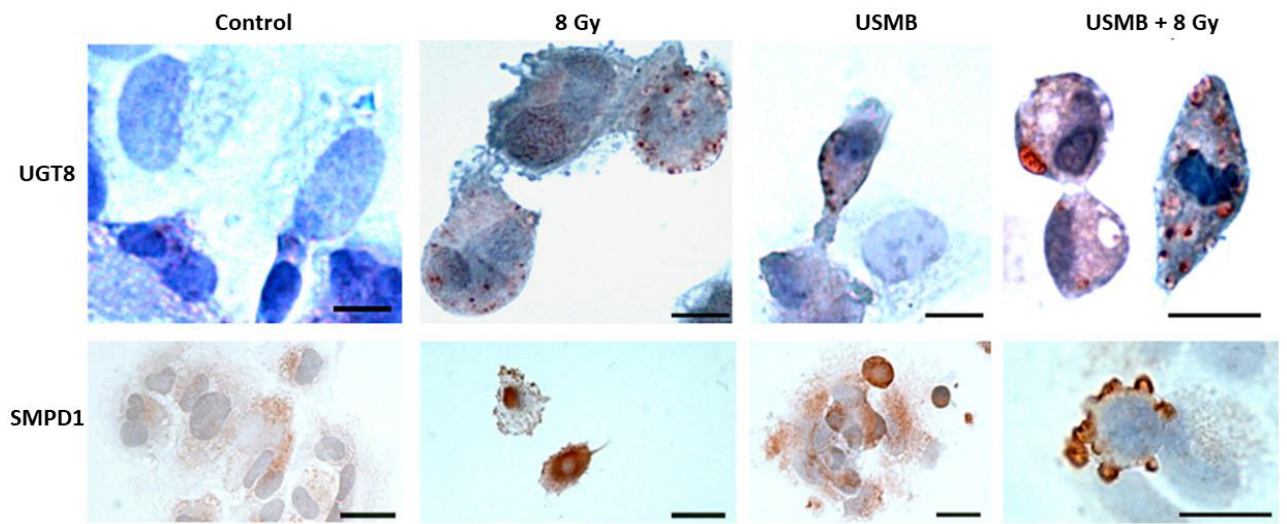
Figure 5. UGT8 and SMPD1 immunohistochemistry of HUVEC following different conditions. The upper panel images depict UGT8 and the lower panel represents SMPD1 following various treat- ments. Both UGT8 and SMPD1 stains were higher in the combined treated group. Cells appeared to have distorted morphology, indicating apoptosis-like features in both UGT8 and SMPD1 combined treated group. Scale bar represents 25 µm for control, 8 Gy, and USMB and 12 µm for USMB + 8 Gy. Abbreviations: HUVEC — human umbilical vein endothelial cells; SMPD1 — sphingomyelin phos- phodiesterase 1; UGT8 — UDP glycosyltransferase 8; USMB — ultrasound-stimulated microbubbles.